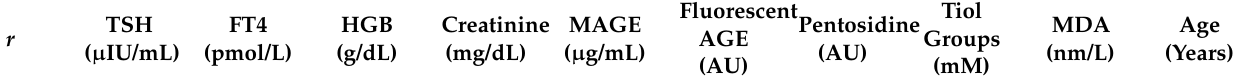
Table 2. The results of correlation analysis between analysed parameters—the first number shows correlation coefficient r , the number in brackets shows p .